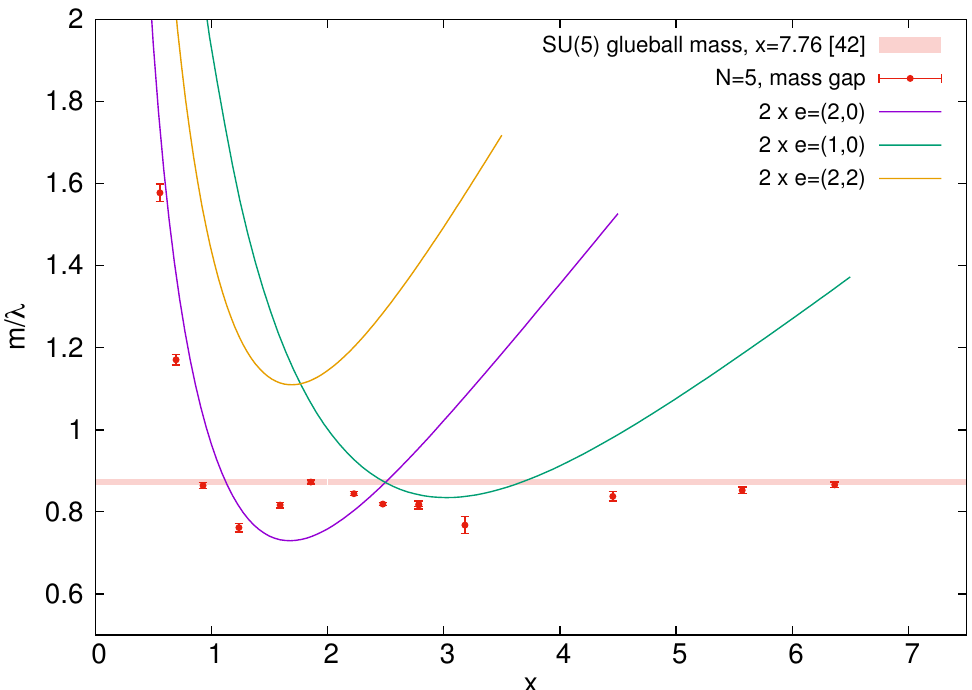
Figure 10. x -dependence of the mass gap in the zero-electric (cid:13)ux sector for the Fibonacci set f N; k g = f 5 ; 2 g . The continuous lines give twice the torelon energy in the corresponding electric (cid:13)ux